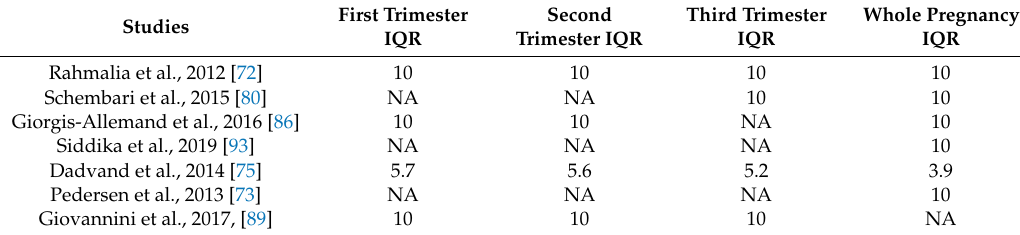
Table A7. IQR table for PM 10 exposure ( µ g / m 3 ).